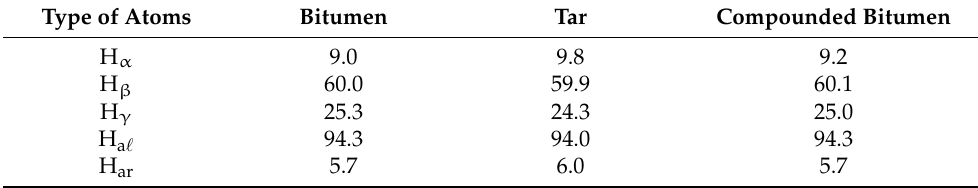
Table 8. Functional groups (% under quantity of 1 H).